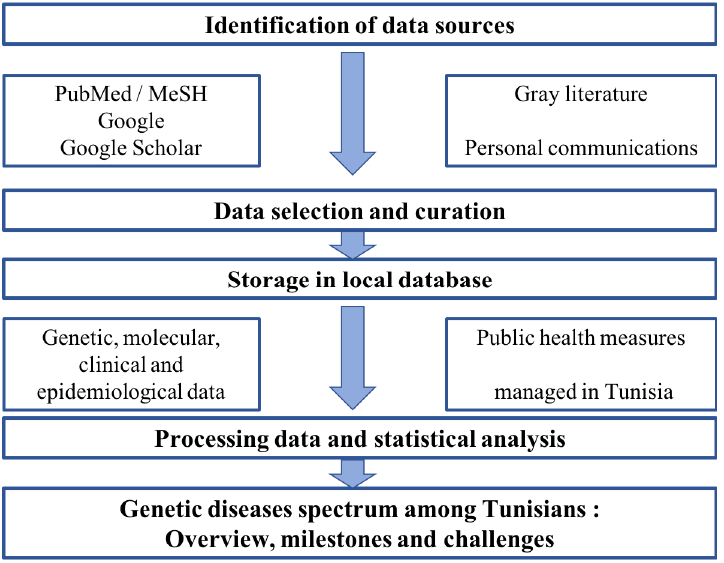
Figure 1. Screening process workflow.